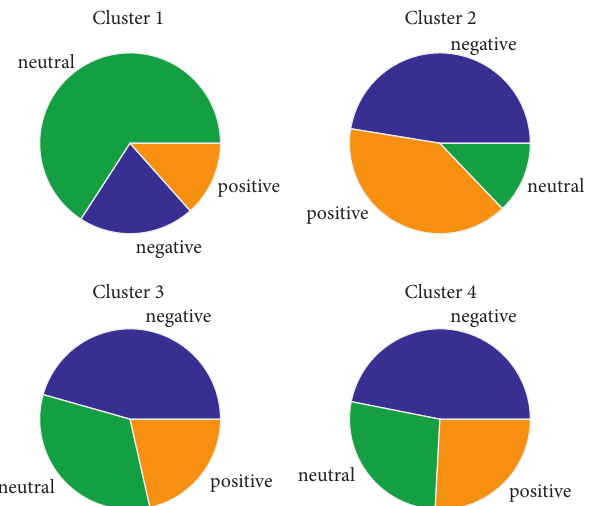
Figure 10: Polarity analysis for the four clusters of Scenario 2 using SLP